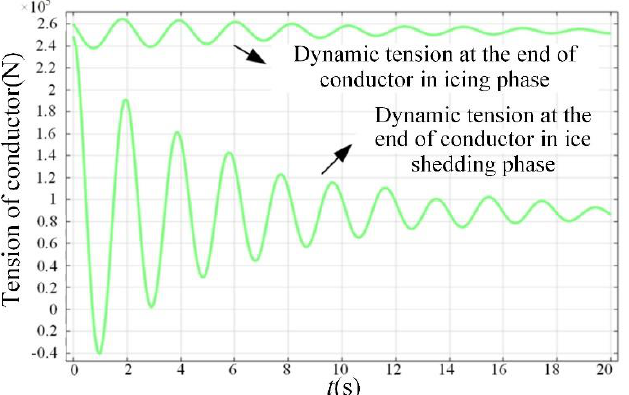
Figure 10. Jump heights of ice-shedding conductors under different arrangement schemes.